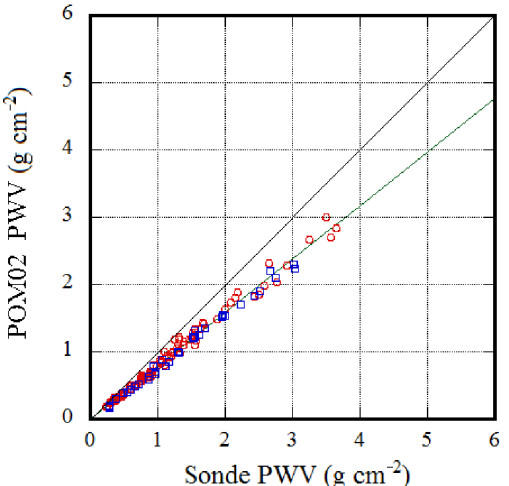
Figure 11. Scatter plot of GPS and radiosonde precipitable water